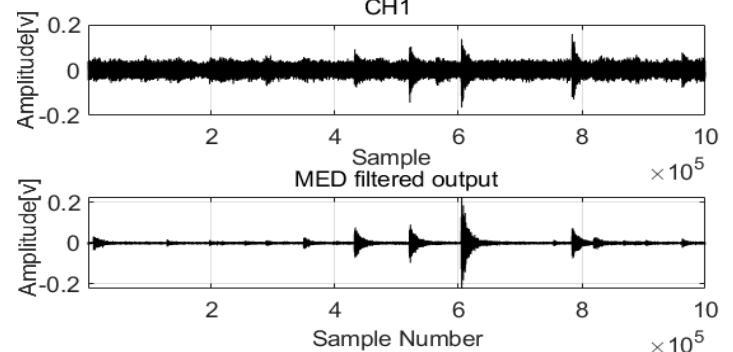
Figure 2. MED method for the acoustic signals in Channel 1.